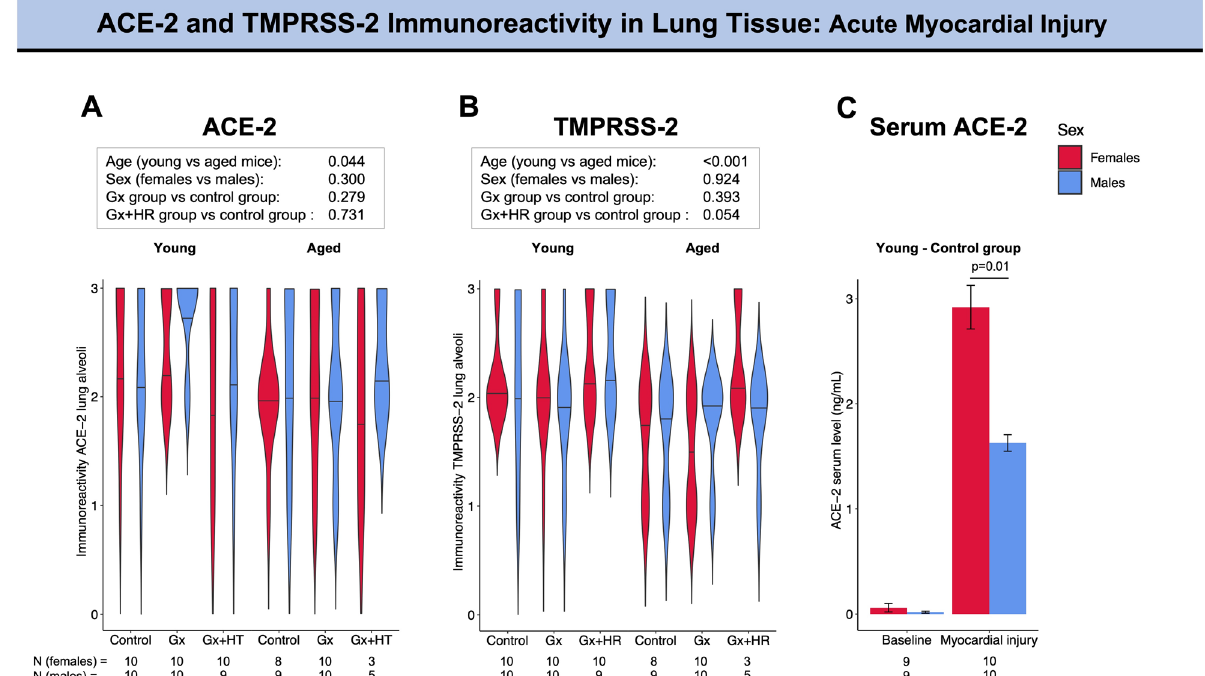
Figure 3. ACE-2 and TMPRSS-2 immunoreactivity in lung alveoli in a murine model of ageing, hormonal manipulation, and myocardial injury. The violin plots provide information on the full data distribution. The horizontal black line indicates the median of the kernel density plot. ( A ) ACE-2 immunoreactivity in young (left panel) and aged (right panel) control animals, gonadectomized animals, and gonadectomized animals receiving long-term hormone replacement following ischemia-reperfusion injury. ( B ) TMPRSS-2 immunoreactivity in young (left panel) and aged (right panel) control animals, gonadectomized animals and gonadectomized animals receiving long-term hormone replacement following ischemia-reperfusion injury. ( C ) Soluble angiotensin-converting enzyme (sACE-2) serum levels in young mice at baseline and following ischemia/reperfusion injury. Ordinal logistic regression was performed to test the association between the level of expression of ACE-2 and TMPRSS-2 with age, sex, and hormonal status. The resulting p-values are reported in the box. Unpaired Student’s t-test was applied for comparison of sACE-2 (only the significant p-value is reported). ACE-2, angiotensin-converting enzyme 2; Gx, gonadectomy; HR, hormone replacement; sACE-2, soluble angiotensin-converting enzyme; TMPRSS-2, transmembrane protease serine